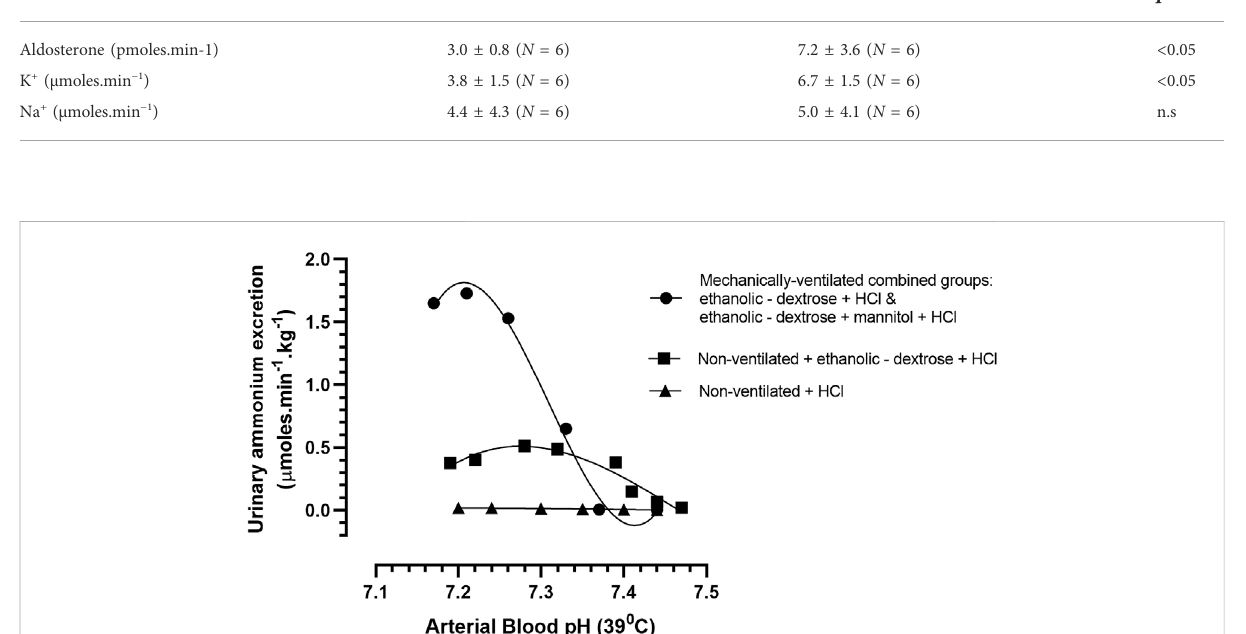
TABLE 2 Urinary excretion of Aldosterone, K+, and Na+ during the intravenous infusion of a solution containing 5% dextrose, 3% ethanol, 5% mannitol, and 0.1 M HCl (Protocol 4). Parameter Control